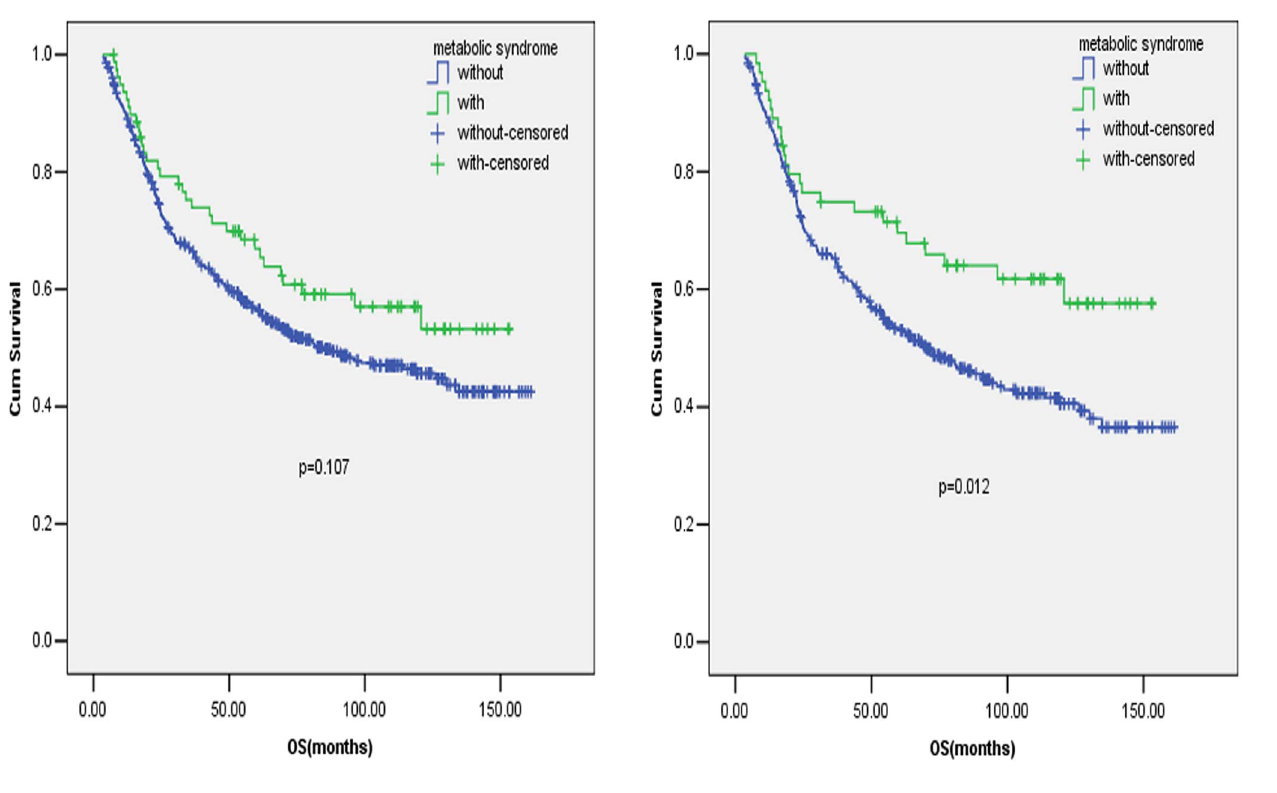
Figure 2. Prognostic value of MetS in early stage gastric cancer patients with old age. Full legend: Survival curves of early stage GC patients with and without MetS in patients aged . 50 years old.